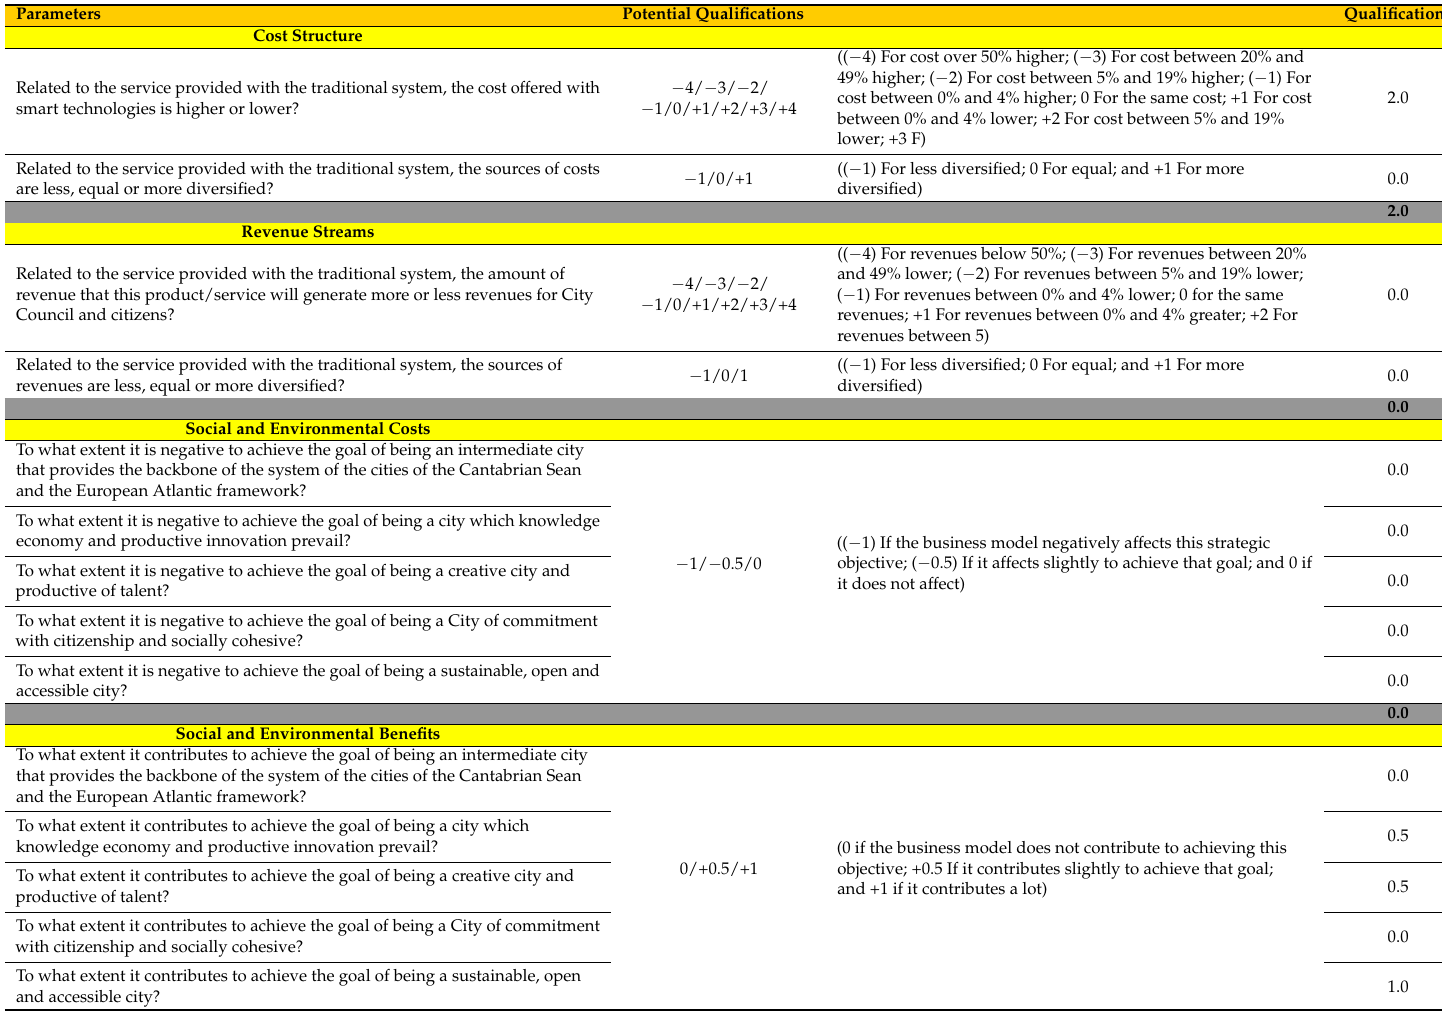
Table 6. Business Model Evaluation Tool of Santander’s street lighting